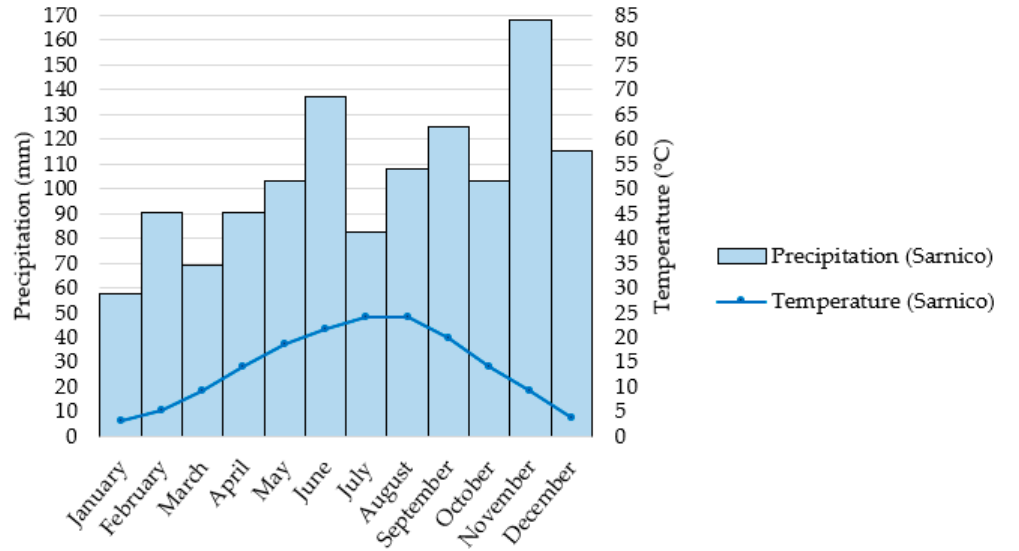
Figure 2. Mean monthly precipitation and temperature recorded at Sarnico (from 2008 to 2011).